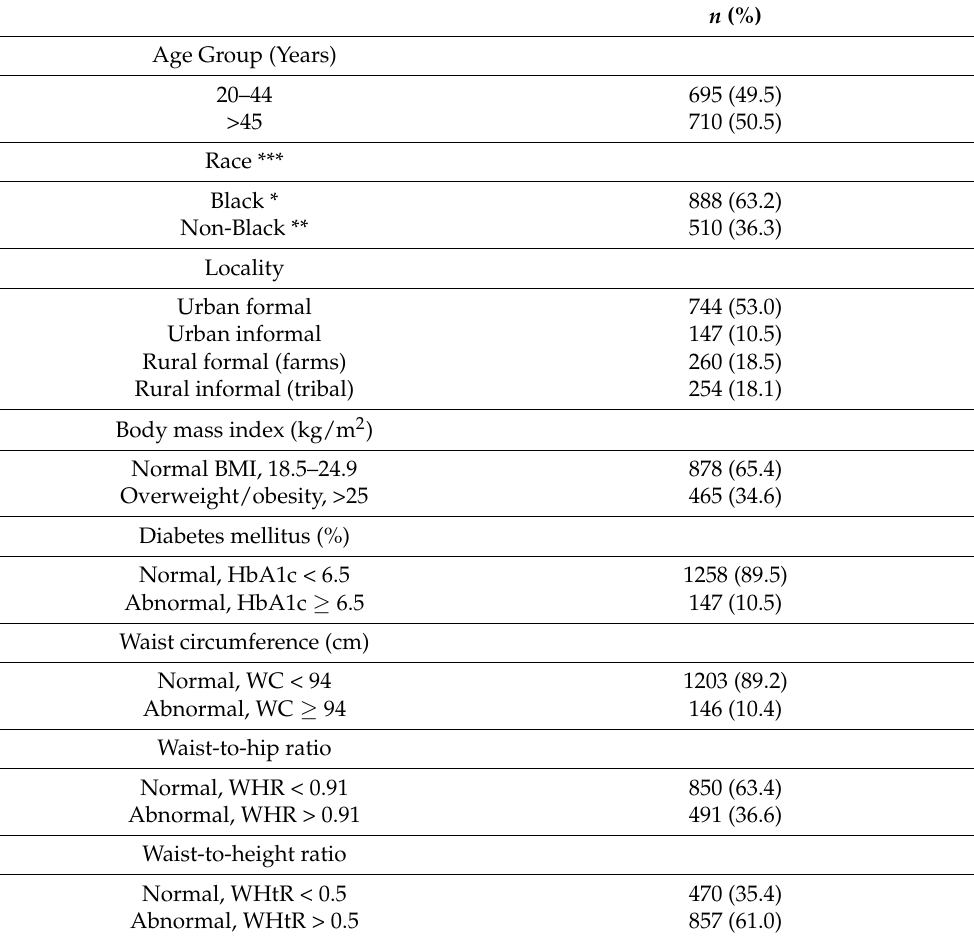
Table 1. Socio-demographic characteristics, anthropometric indices and HbA1c outcome of South African males aged 20 years and older: SANHANES-1.